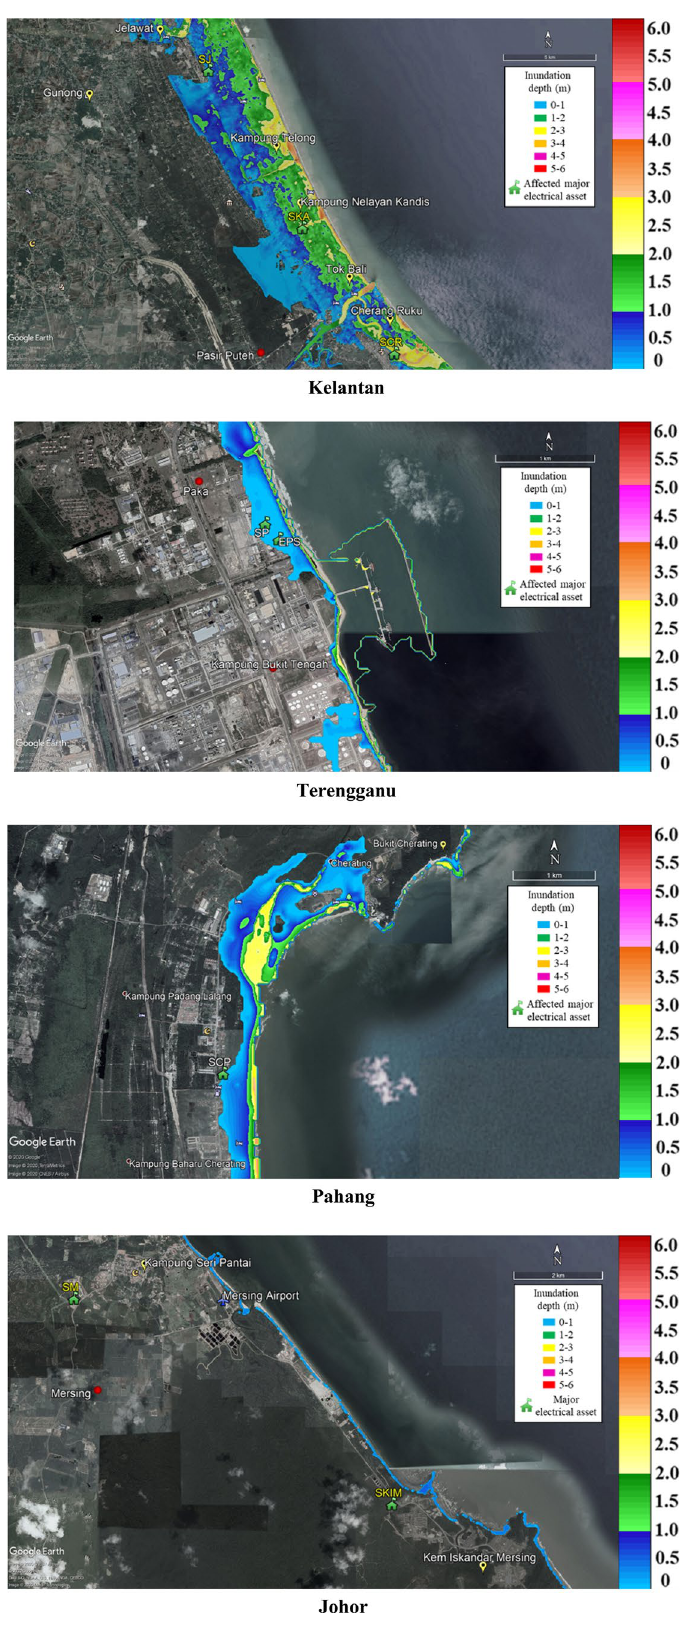
Fig. 12 anticipated major elec- trical assets to be submerged by tsunami at Mw 9.0 for the four study